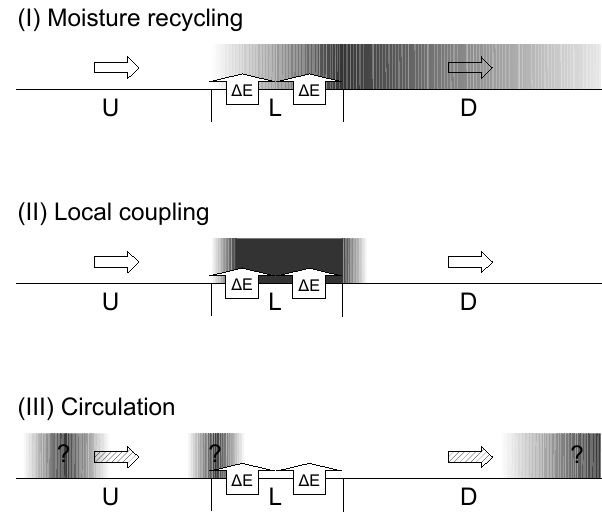
Fig. 1. Schematic of three mechanisms via which evaporation af- fects precipitation. The effect of each mechanism is shown isolated from the others. The arrows pointing to the right indicate the wind direction. The colour gradients indicate the regions where precipi- tation responds (either positively or negatively). U=upwind region, L=local region, D=downwind region, 1E =imposed evaporation anomaly. (I) Moisture recycling: The precipitation response, caused by changes to the atmospheric moisture budget, grows gradually over the region of the imposed evaporation anomaly, then decays (slowly) over the downwind region. (II) Local coupling: The pre- cipitation response, caused by changes to the thermal structure of the atmosphere, collocates with the imposed evaporation anomaly. A slight downwind shift is indicated because the structural change may need some time to develop. (III) Circulation: The precipita- tion response may occur anywhere, caused by changes to the 3-D large-scale atmospheric circulation (indicated by the hatching of the wind-arrows). While mechanism (I) accounts for the effect of 1E on the vertically integrated atmospheric moisture budget, mecha- nisms (II) and (III) account for modified energetics that come along with 1E (in particular changes in